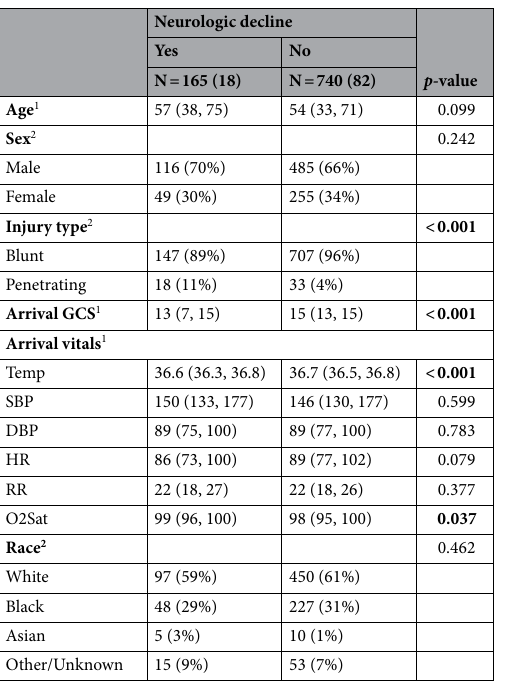
Table 1. Demographic, clinical, and injury characteristics. Statistical significance and p-values were assessed for ordinal variables using Wilcoxon rank sum tests 1 and for categorical variables using Chi-squared tests 2 . GCS = Glasgow coma scale; Temp = temperature (degrees Celcius); SBP = systolic blood pressure (mmHg); DBP = diastolic blood pressure (mmHg); HR = heart rate (beats per minute); RR = respiratory rate (breaths per minute); O2Sat = oxygen saturation (%). Significant values are in bold.